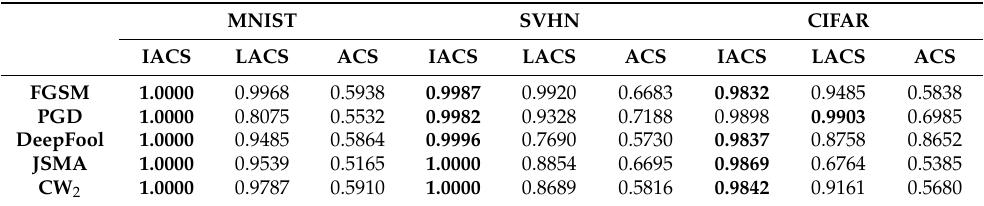
Table 5. A comparison of discrimination power (AUC score of a logistic regression classifier) among IACS, LACS, and ACS methods on the different datasets and with different attacks. The best results are highlighted in bold.